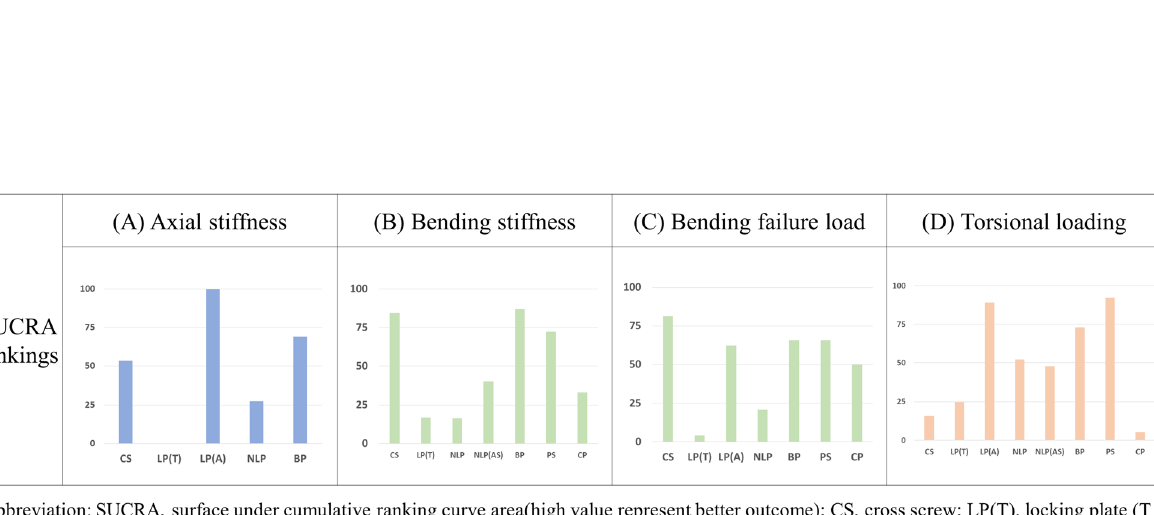
Figure 3. Relative ranking probability of different radial neck fracture fixation methods for ( A ) axial stiffness, ( B ) bending stiffness, ( C ) bending failure load, and ( D ) torsional stiffness. CS, Cross screw; LP(T), Locking plate (T plate); LP(A), Locking plate (anatomic plate); NLP, Nonlocking plate; NLP(AS), Nonlocking plate with augmented screw; BP, Blade plate; PS, Parallel screw; CP, Cross